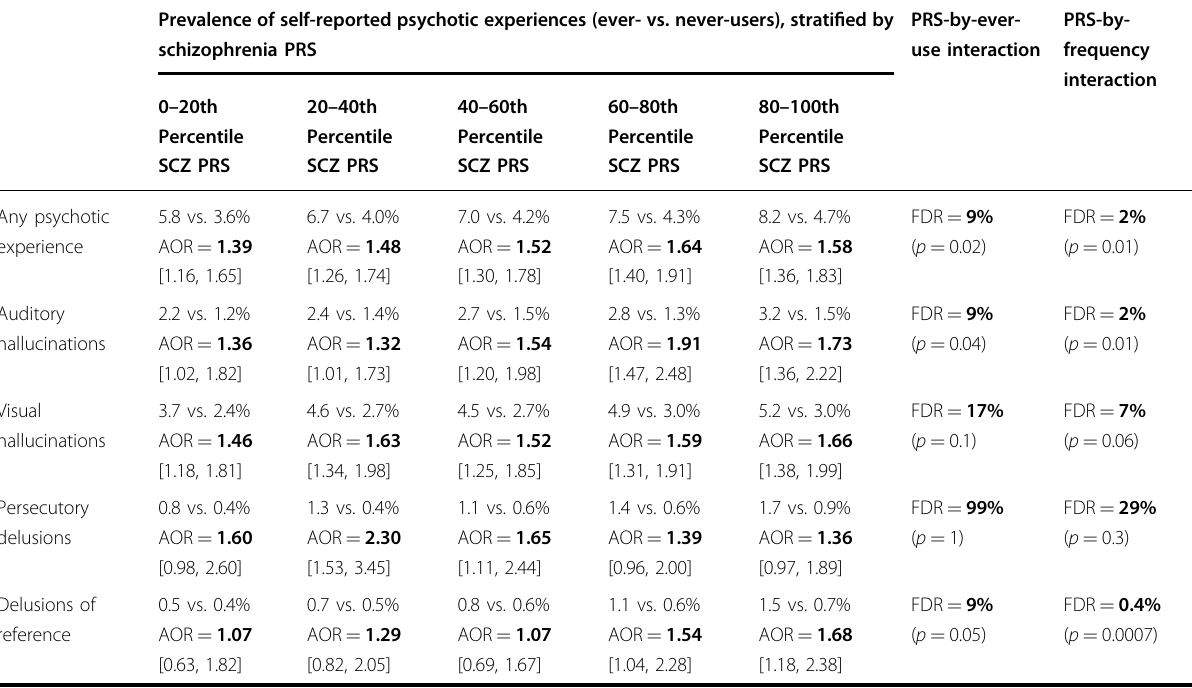
Table 5 Schizophrenia PRS modulates the association of cannabis use with self-reported psychotic experiences. Prevalence of self-reported psychotic experiences (ever- vs. never-users), strati fi ed by schizophrenia